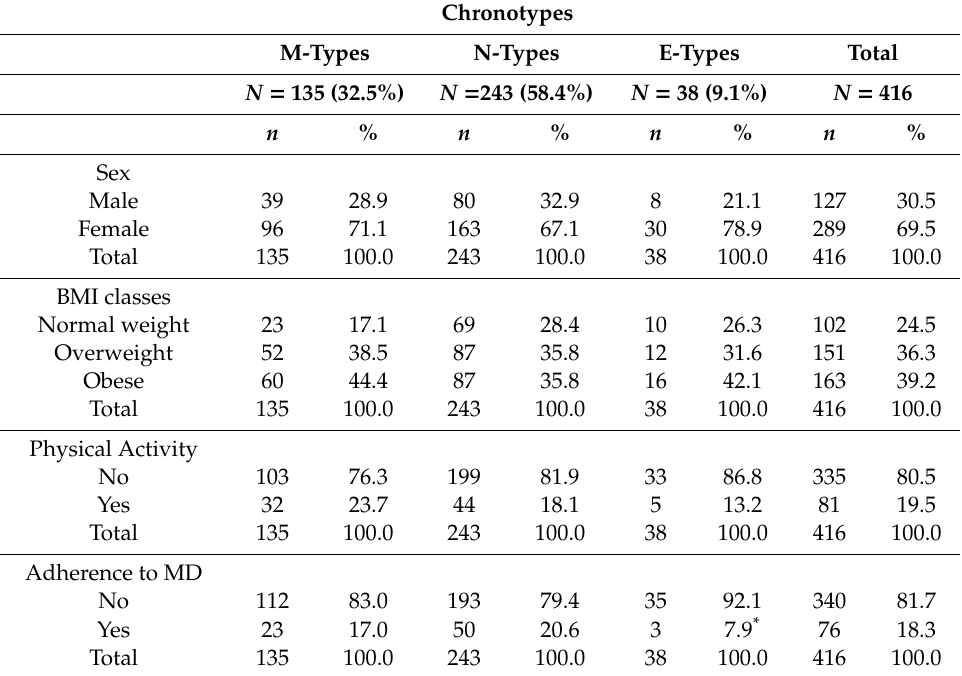
Table 2. Prevalence of sex, BMI classes, and adherence to MD among